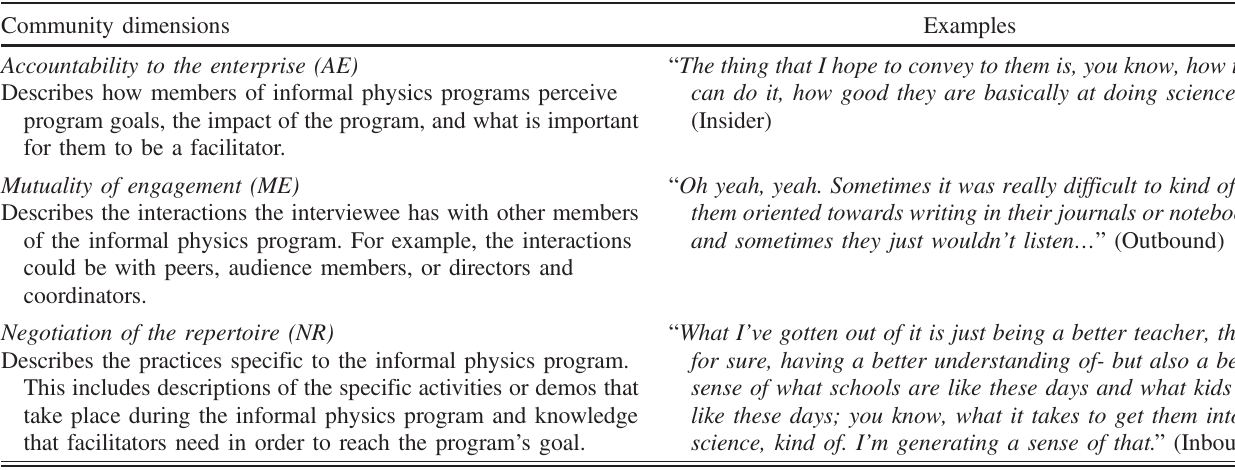
TABLE I. Description and examples of the community dimension